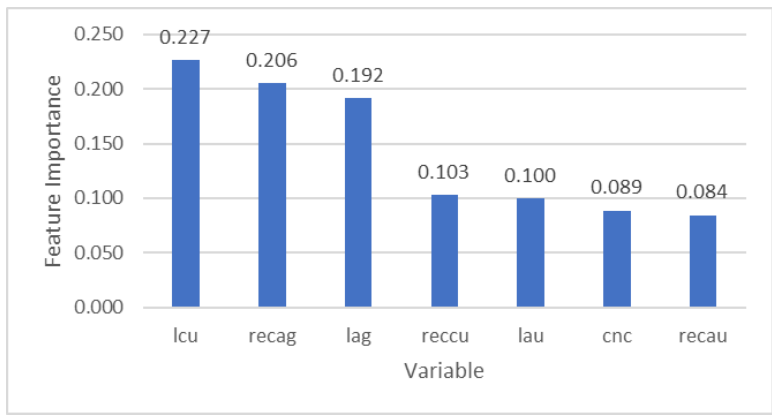
Figure 7. Feature importance plot of each variable resulting from the RF model.